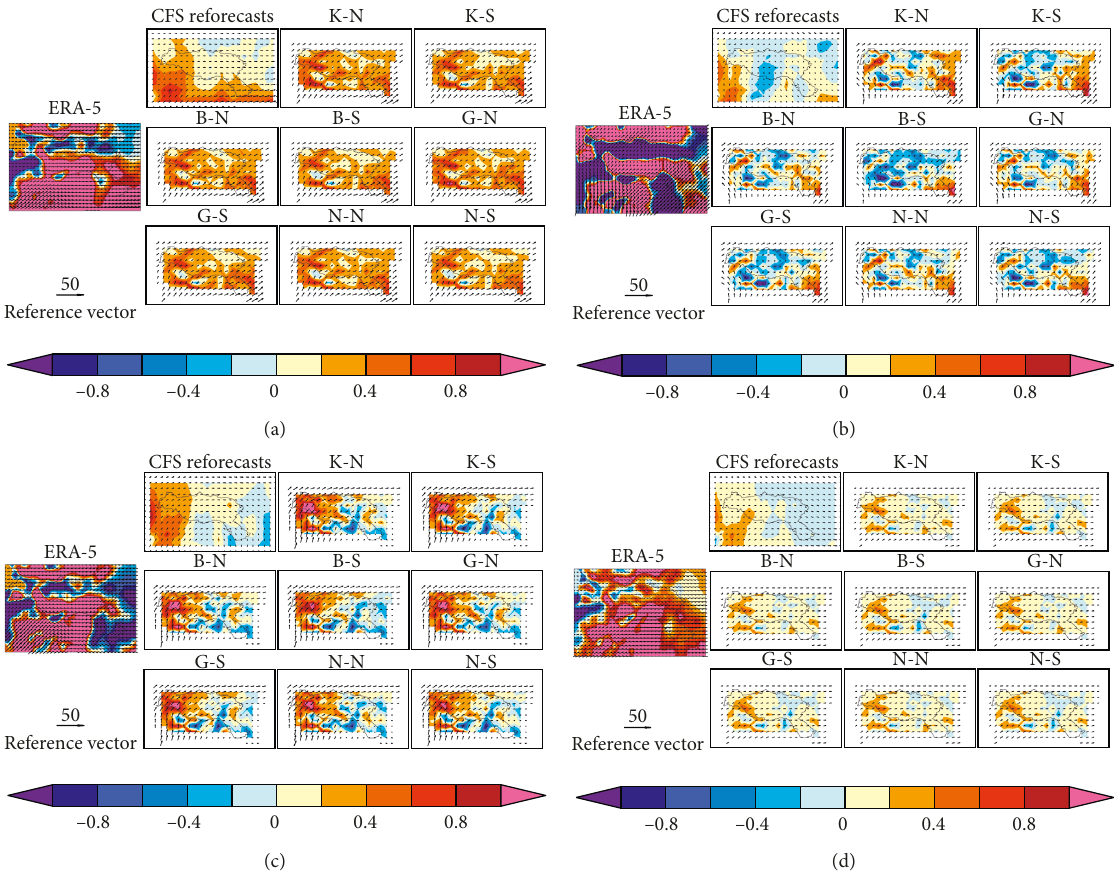
Figure 6: Spatial patterns of vertically integrated (from 1,000 to 300hPa) moisture fluxes (100 g/cms − 1 ) (arrows) and moisture flux convergence (multiplied by 10 − 5 s − 1 ) (shaded areas) of ERA-5 reanalysis, CFS reforecasts, and the WRF model in (a) spring, (b) summer, (c) autumn, and (d)